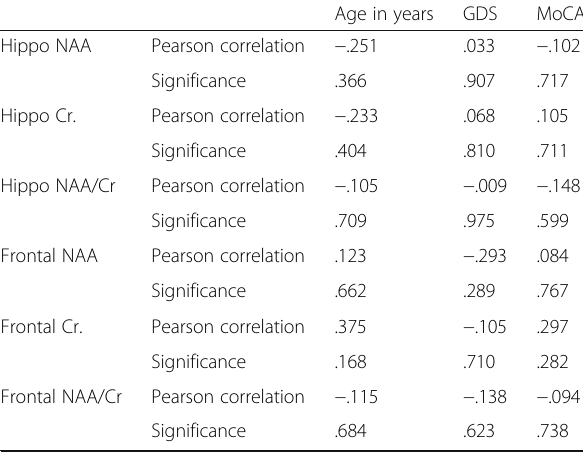
Table 5 Correlations between age, clinical, and spectroscopic data in normal